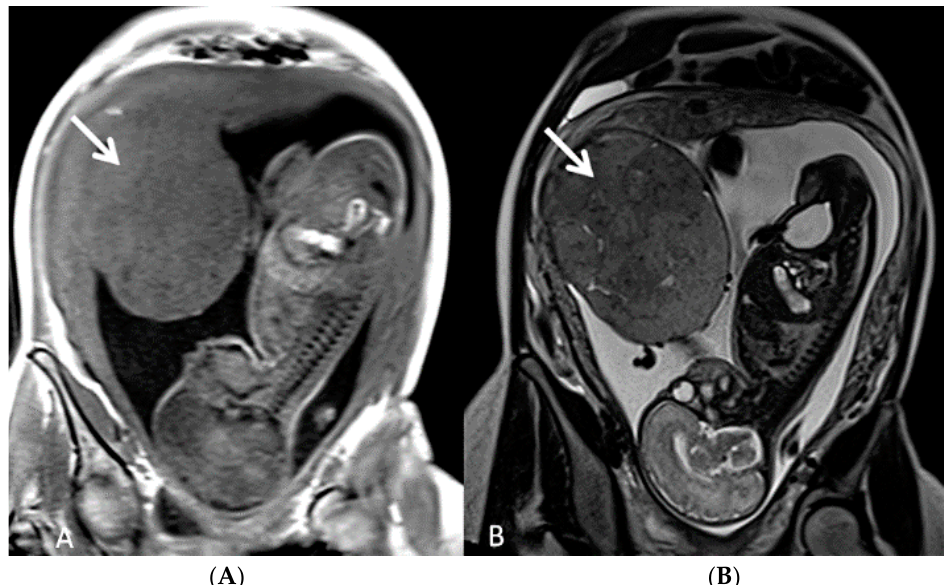
Figure 10. ( A , B ) Fetal MRI (coronal T1 and T2) in a case of circumvallate placenta at 28 week’s gestation (white arrows).